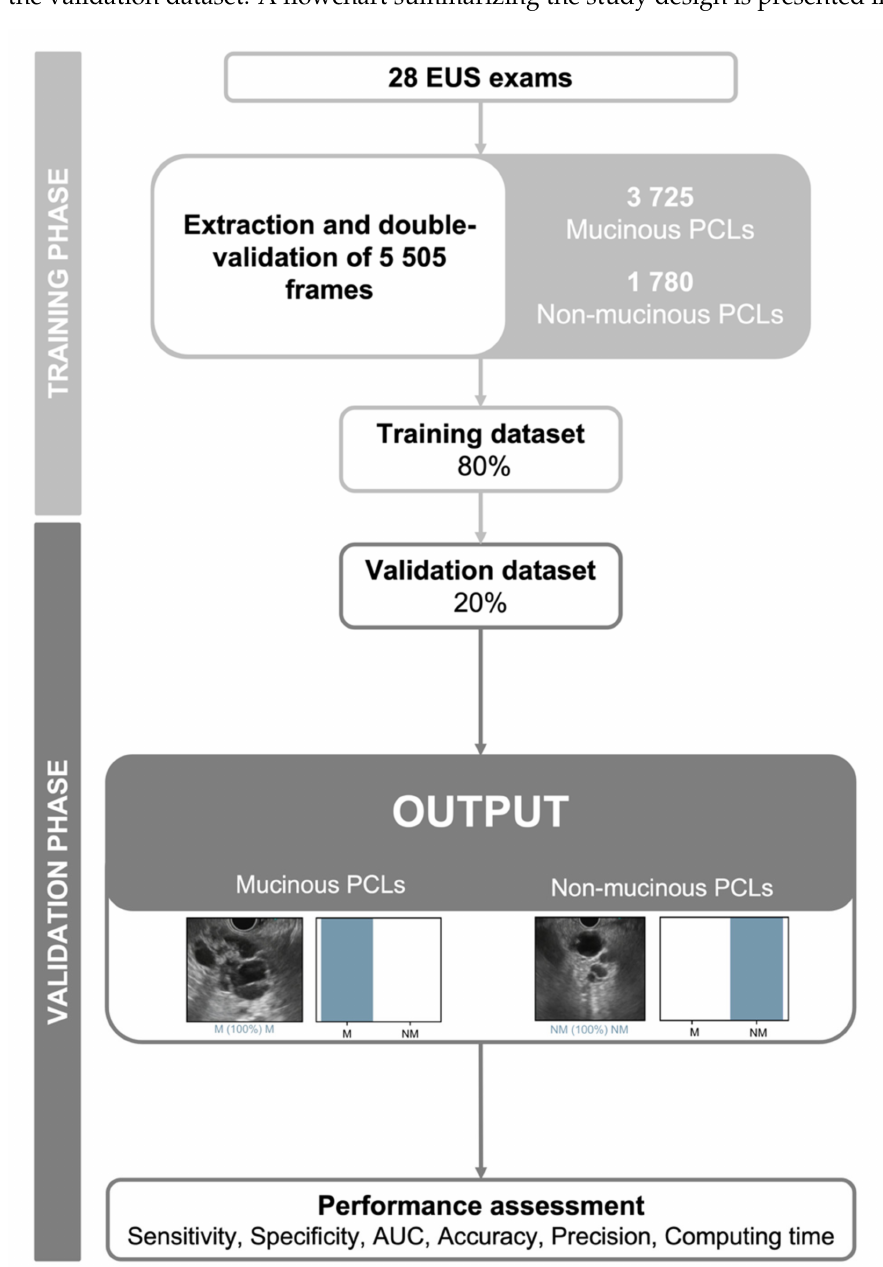
Figure 1. Study design for the construction of the convolutional neural network and subsequent evaluation of its performance. EUS—endoscopic ultrasound; PCLs—pancreatic cystic lesions; M—mucinous pancreatic cystic lesion; NM—non-mucinous pancreatic cystic lesion; AUC—area under the receiving operator